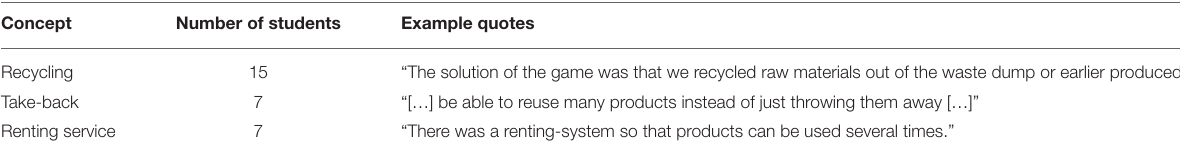
TABLE 6 | Concepts of the circular economy listed in the reflection report.